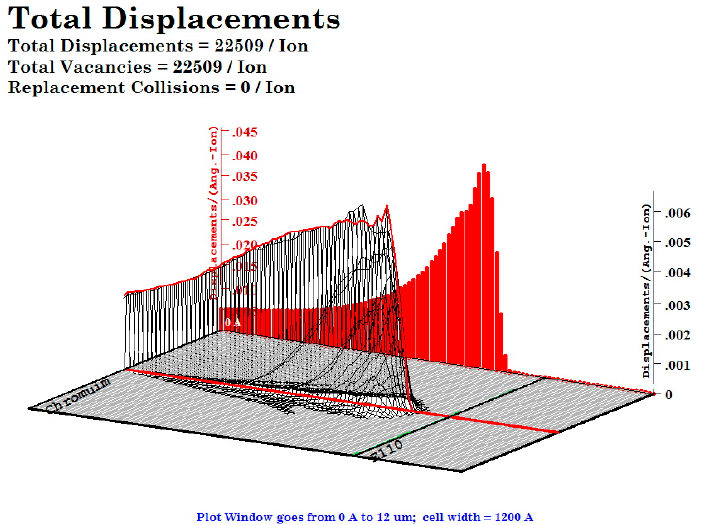
Figure 11. Damage caused by 120 MeV Mo in E110 alloy, coated with 9 µm thin film of Cr. The maximum damage that could be caused by rhodium (Rh) in E110 is shown in Figure 12. This is estimated to be ~ 29,895 vacancies/ion. It could be seen that this number is higher, when compared by the previous calculations, for the damage caused by Mo with the same maximum recoil energy which is estimated to be 26,826 vacancies/ion. This difference is justifiable, given the variations in atomic masses for the two FPs, the higher the mass, the more the displacement damage, created by the high energetic particle. Lighter energetic ions will induce lower displacements, however; it will travel longer inside the target until come to rest, and this means longer implantation depths. A thin film of 9 µm thickness will be able to contain this energetic FP (Figure 13) and eliminate its damaging effect on the nuclear fuel cladding material.